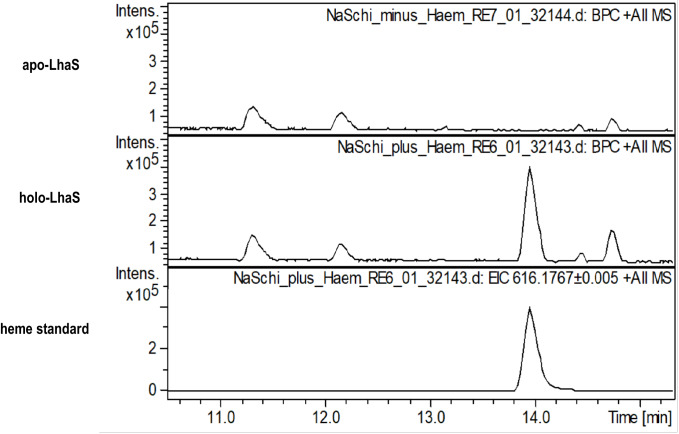
High resolution mass spectra of apo- and holo-LhaS.Spectra of apo-LhaS isolated from E. coli grown in RPMI medium (upper panel), holo-LhaS isolated from LB-medium (middle panel) and a heme standard (lower panel) were recorded on a HPLC-UV-HR mass spectrometer. The samples were diluted with MilliQ-H2O and applied to a Dionex Ultimate 3000 HPLC system that is coupled to the MaXis 4G ESI-QTOF mass spectrometer.